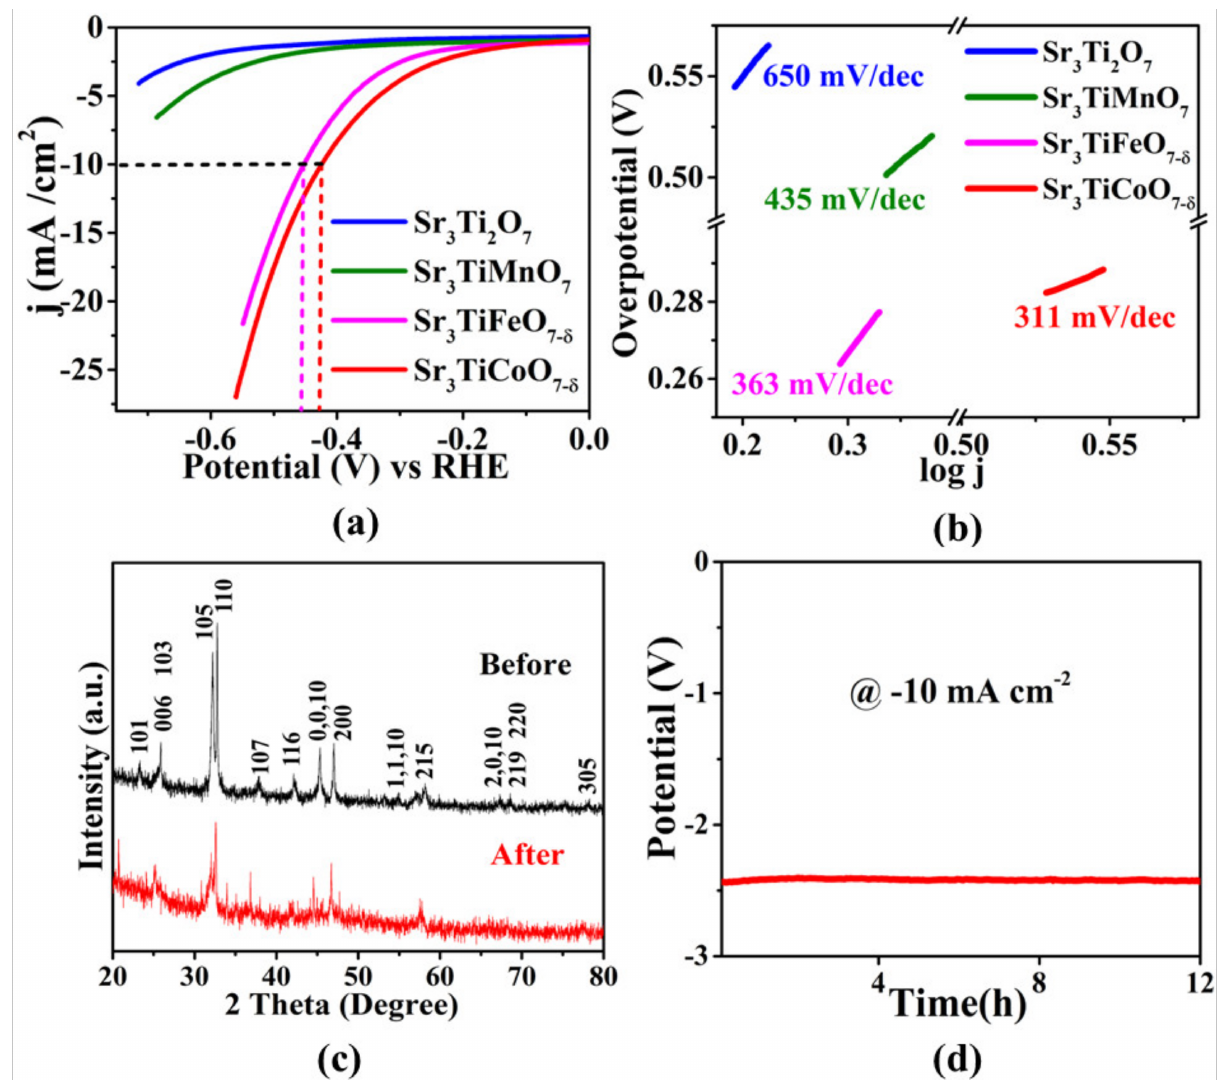
Figure 4. HER activity in 0.1 M KOH ( a ) polarization curves; ( b ) Tafel plots; ( c ) X-ray diffraction data of Sr 3 TiCoO 7 − δ , before and after 100 cycles of OER; ( d ) chronopotentiometry response of Sr 3 TiCoO 7 − δ using a two-electrode cell consisting of nickel foam